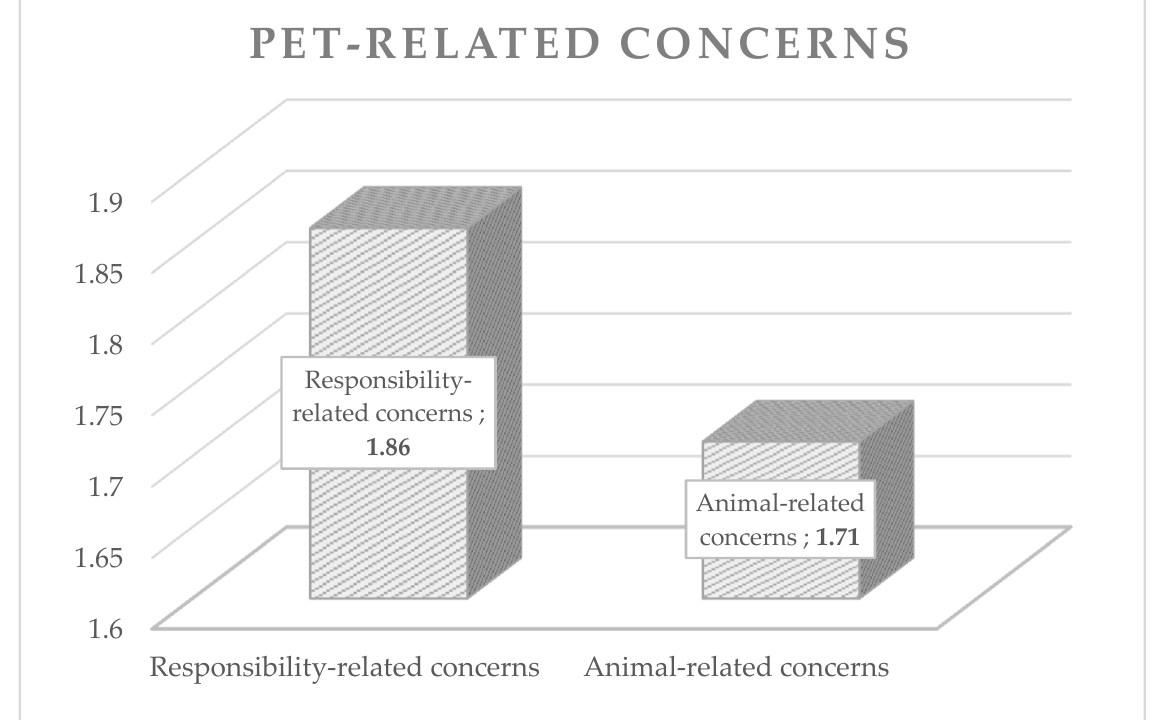
1.61.651.71.751.81.851.9 Figure 1. Mean values of pet-related concerns. Figure 1. Mean values of pet-related Figure 2. Mean values of pandemic-related concerns. To determine relationships between pet-related and pandemic-related concerns, Pearson correlations were conducted between the pre-calculated factors of pet-related concerns (animal-related concerns and responsibility-related concerns) and pandemic-